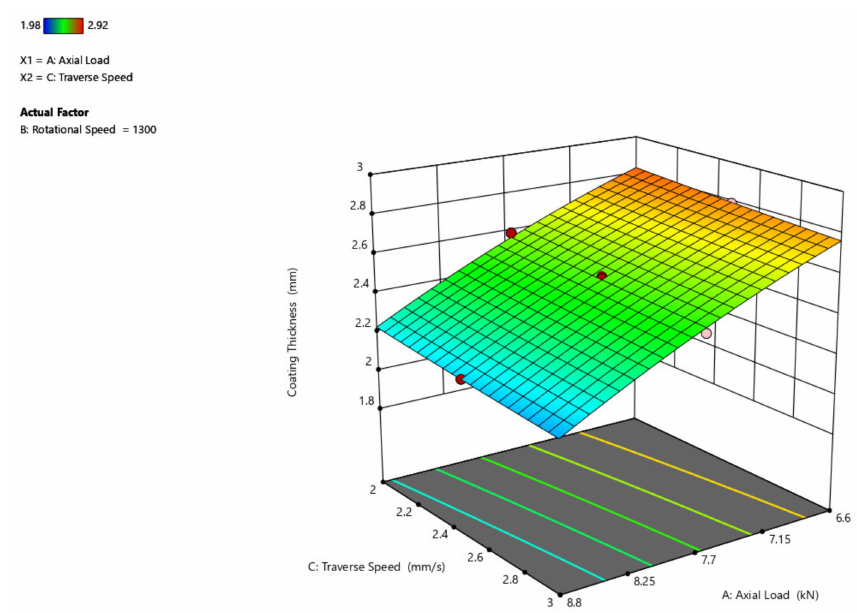
Figure 6. Interaction plot of traverse speed and axial load on coating thickness (C t ). The effect of rotational velocity and traverse speed over the thickness of the coating is shown in Figure 7. An increase in rotational speed from 1100 rpm to 1500 rpm decreases the thickness of the coating to some degree to around 0.2 mm. By increasing the traverse speed from 2 mm/s to 3 mm/s, the thickness of the coating remains constant without showing any difference because of the region of contact between the substrate and the